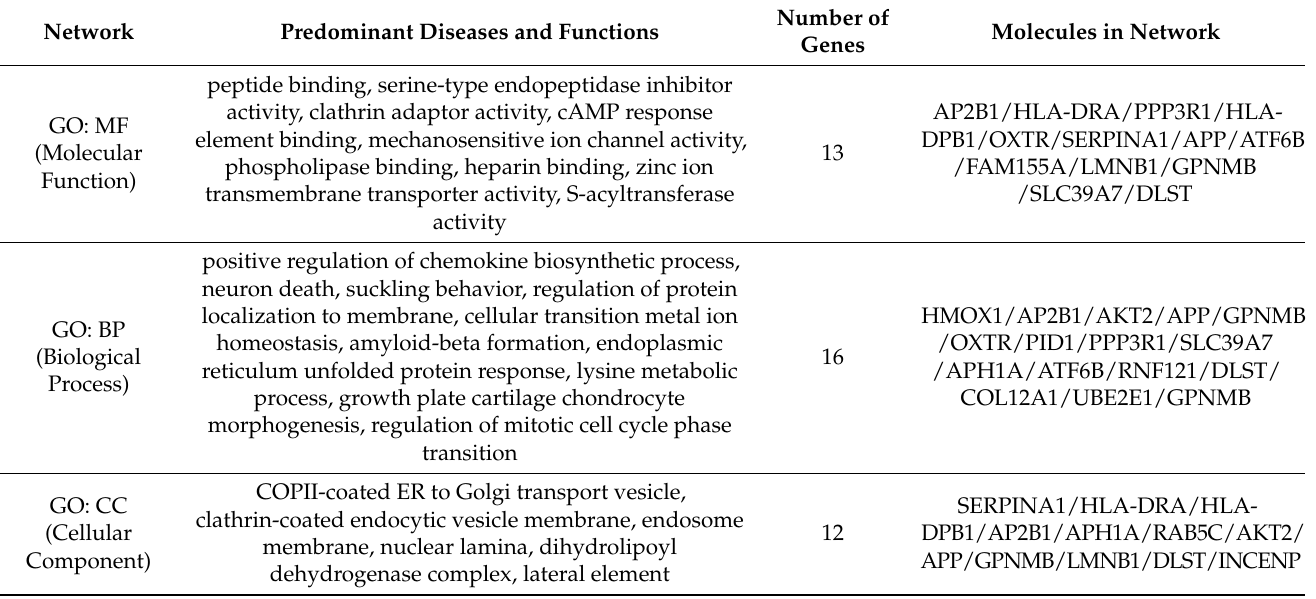
Table 2. Top three networks associated with genes targeted by luteolin in breast